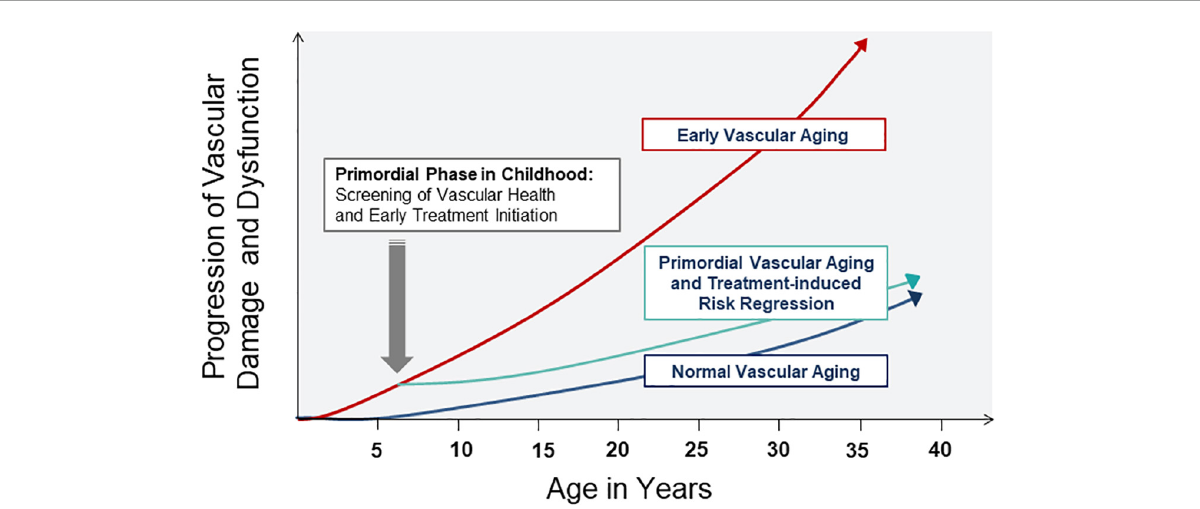
FIGURE1 Concept of normal, primordial and early vascular aging across the lifespan. Screening in the primordial phase of vascular aging allows for timely detection of subclinical atherosclerosis and initiation of treatment strategies to reverse vascular damage and dysfunction in childhood and later in